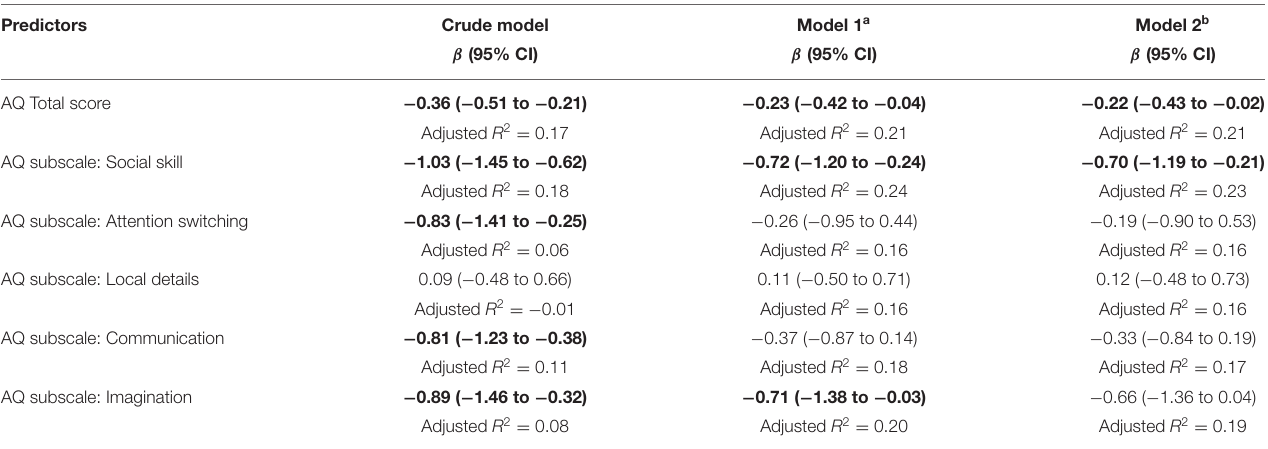
TABLE 3 | Association between AQ Total score and each sub-scale score and